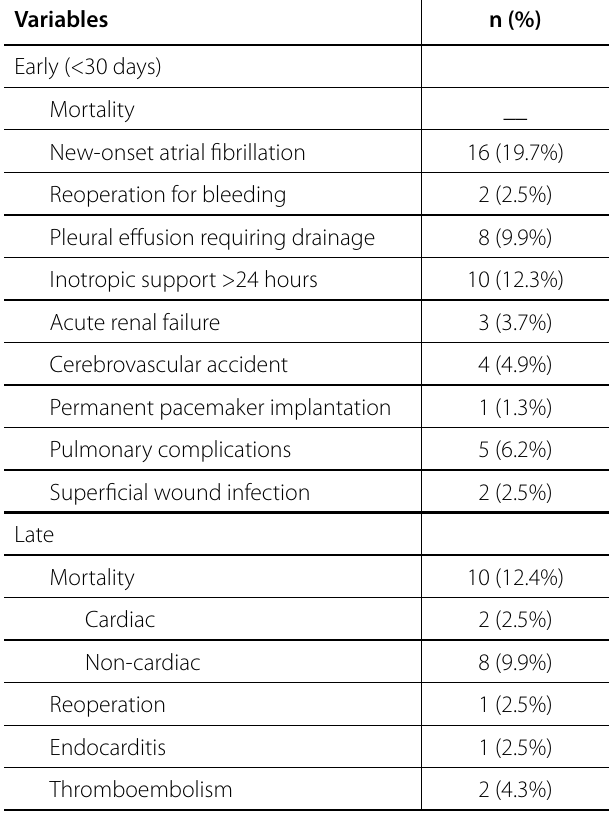
Table 3 . Early and late morbidity and